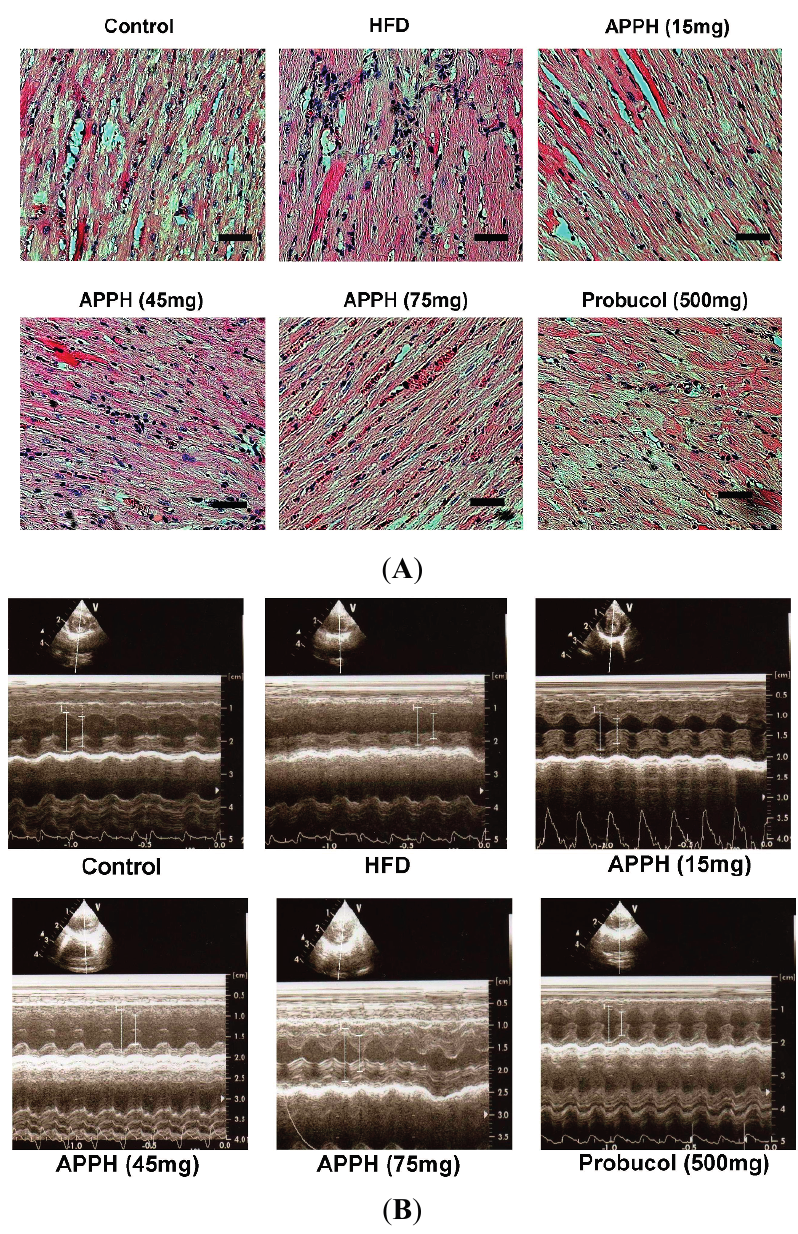
Figure 1. Asessments of cardiac features. ( A ) Hematoxylin and eosin (H & E) staining of rat hearts. Cell nuclei are stained in blue, and other intracellular or extracellular proteins are stained in pink. All heart sections were obtained from the ventricular septum of each rat (Bar length = 50 μ m); ( B ) Echocardiography images of each group. The heart functions of each group were compared by the left ventricular systolic and diastolic distances